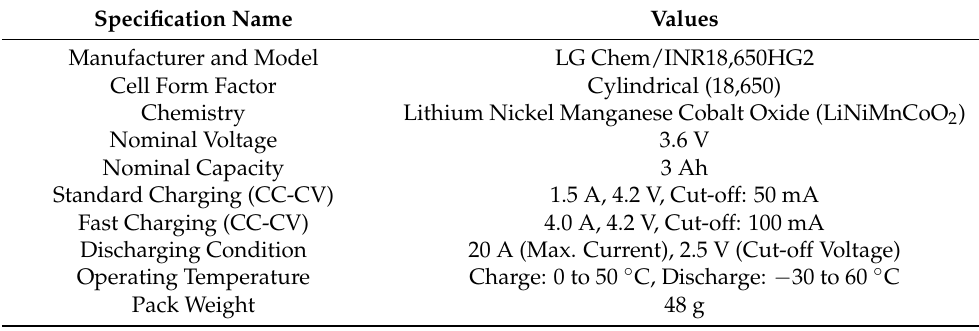
Table 1. Specifications of 18,650 LIB cell under test.